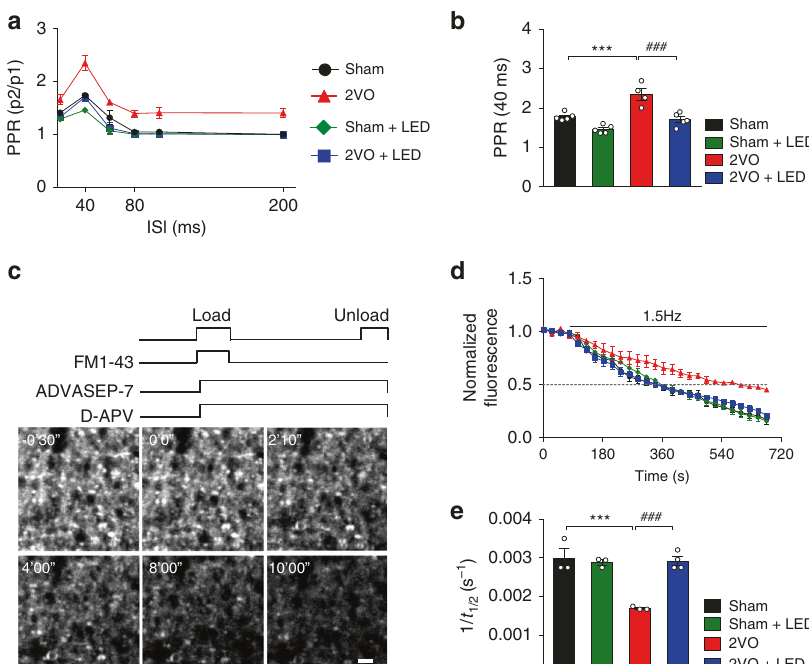
Fig. 5 40 Hz light stimulation enhanced CA3-CA1 presynaptic short-term plasticity. a Hippocampal slices from the Sham, Sham + LED, 2VO, and 2VO + LED groups at 3 d after the 2VO surgery were subjected to PPR measurements. The inter-stimulus intervals (ISI) were from 20 – 200 ms. The ratios of the slope of the second response to that of the fi rst at the 40 ms ISI for a were measured and plotted in b (Sham: n = 5 mice; Sham + LED: n = 5 mice; 2VO: n = 4 mice; 2VO + LED: n = 5 mice). c The protocol for determining the kinetics of FM1-43 release from presynaptic terminals. Presynaptic terminals were labeled by exposure to 5 µ M FM1-43 (numbers indicate time in minutes and seconds; zero time represents the beginning of the unloading stimulation; Scale bar = 2 µ m). The fi rst image was taken before unloading stimulation. d Normalized fl uorescence intensity decay of puncta to the initial FM1-43 loading intensity were plotted. Each point represents the average of a total of 10 – 15 boutons from different slices of mice. The rate of puncta unloading in brain slices (1/t 1/2 ) was plotted and shown in e (Sham: n = 3 mice; Sham + LED: n = 3 mice; 2VO: n = 3 mice; 2VO + LED: n = 4 mice). Data represent the mean ± SEM. Error bars indicate SEM. ***, ### P < 0.001. The test used in b , e 2ANOVA with Tukey ’ post hoc test. Source data are provided as a Source Data fi RGS12 expression in the 2VO brain (Fig. 8). The decoy RGS12 peptide GK23 has an identical peptide sequence to that of the N- VGCC centered around Tyr-804. The GK23 sequence was com- pletely lacking in L-VGCC, con fi rming the speci fi city of GK23 (Supplementary Fig. 8a). GK23 signi fi cantly increased PPR compared with the control peptide GK13 (Supplementary Fig. 5c, d), demonstrating its effectiveness. RGS12 decoy peptide GK23 was delivered to the left cerebroventricle using an Alzet ® osmotic pump followed by 2VO surgery and 40 Hz light treatment. As shown in Fig. 8(a, c), GK23, and ω -conotoxin GVIA signi fi cantly enhanced PPR of the 3 d 2VO + LED group compared with the GK13-treated 2VO + LED group (1ANOVA, F (2, 6) = 5.559, P = 0.0431, Dunnett ’ s post hoc test, P GK23 vs. GK13 = 0.0351, P GK23 vs. tion of 40 Hz light-induced presynaptic plasticity. FM1-43 was also used to directly image presynaptic vesicle exocytosis. Acute hippocampal slices from the above-treated 2VO + LED mice were used. The halftime of puncta intensity decay (1/t 1/2 ) was signi fi cantly reduced in GK23, and ω -conotoxin GVIA treated